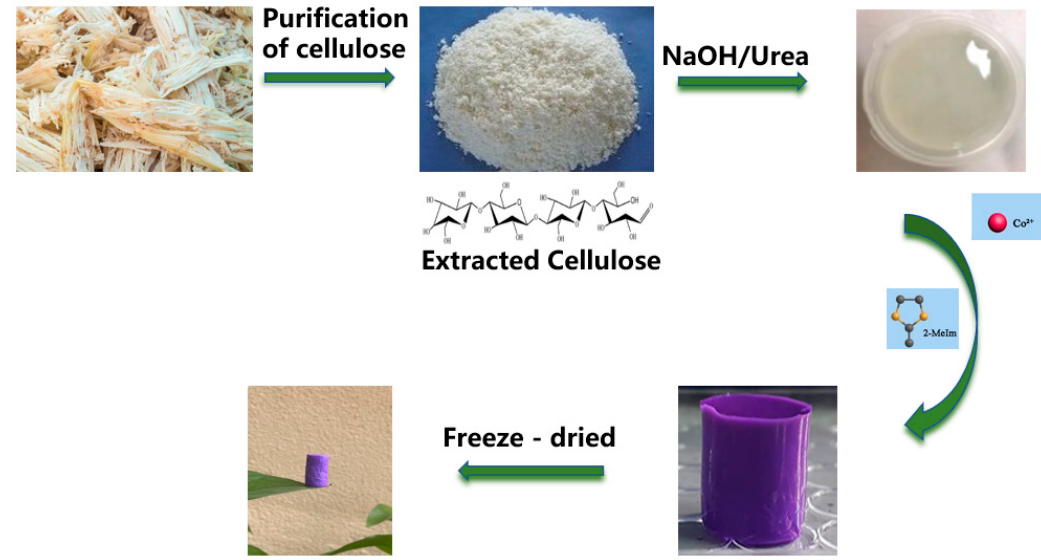
Figure 1. Schematic illustration of the fabrication process of Co-ZIF@GEL.